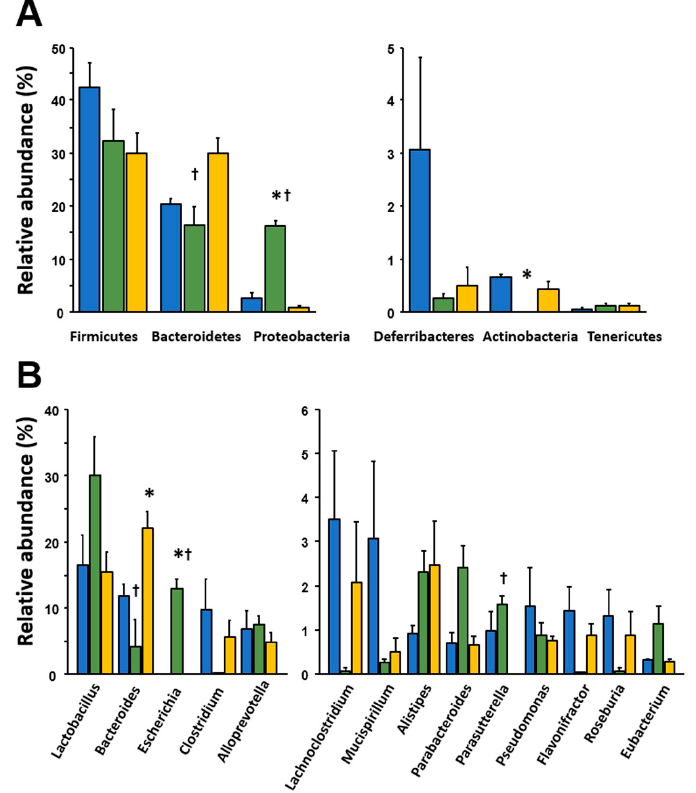
Figure 1. Effect of treatment with vancomycin or polymyxin B on gut microbiota. ( A ) Unweighted UniFrac principal coordinate analyses (PCoA) showing clustered communities of intestinal microbiota in the experimental mice. PCo1 and PCo2 describe the indicated percentage of variation on the x-axes and y-axes, respectively. ( B ) Analysis of operational taxonomic units (OTUs). Alpha-diversity of gut microbiota ( C , Chao1; D , Shannon Index). Results are expressed as the mean ± SE (n = 3 in each group). Significant differences between two groups at * p < 0.05. Significance of differences was determined by Welch’s t -test with Benjamini–Hochberg correction. Cont, control; VAN, vancomycin; PB, polymyxin B.